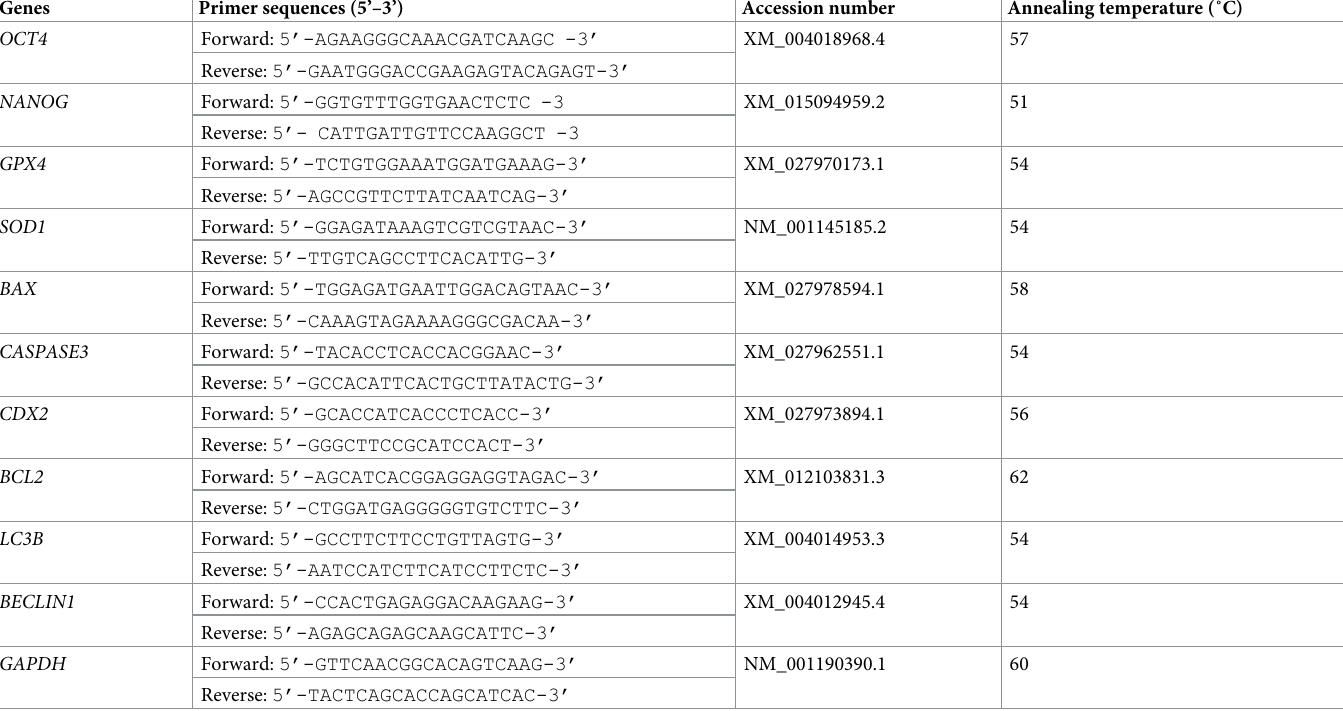
Table 2. Primer sequences for